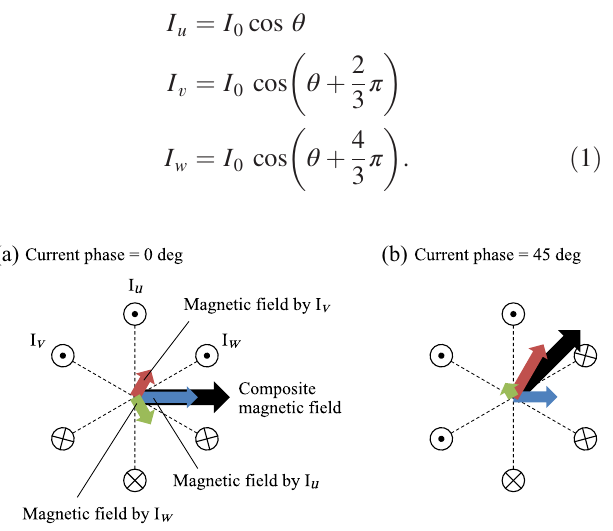
FIG. 3. Cross-section of SCMs: (a) DW-SCM, (b) CW-SCM, and (c) cos θ